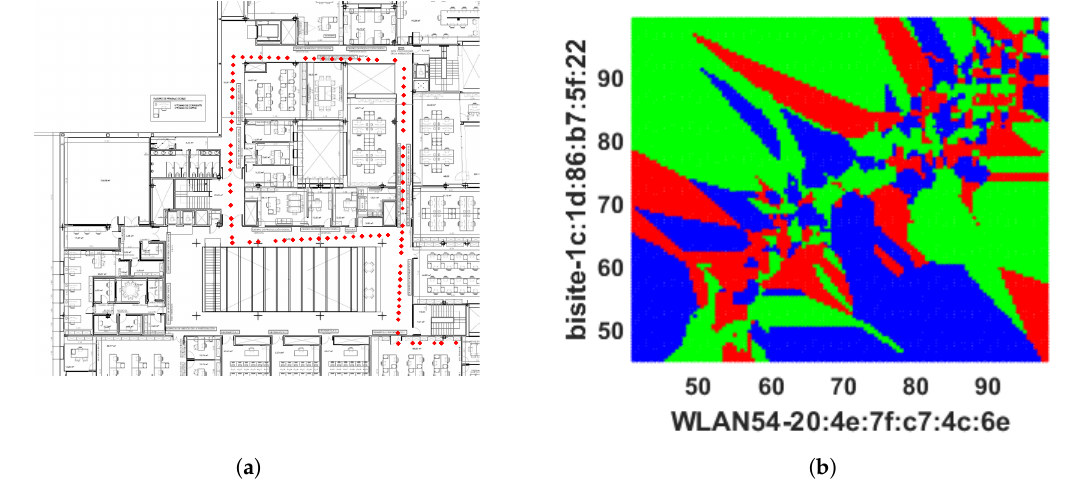
Figure 6. Prediction results obtained from 3 NN Eu classifier: ( a ) the route predicted by 3 NN Eu classifier; and ( b ) 2D decision boundary formed by 3 NN Eu classifier.